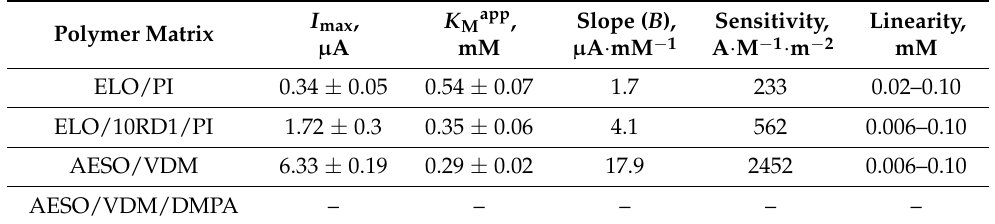
Table 4. Comparison of the Main Operational Parameters of the Biosensors Based on Different Polymer